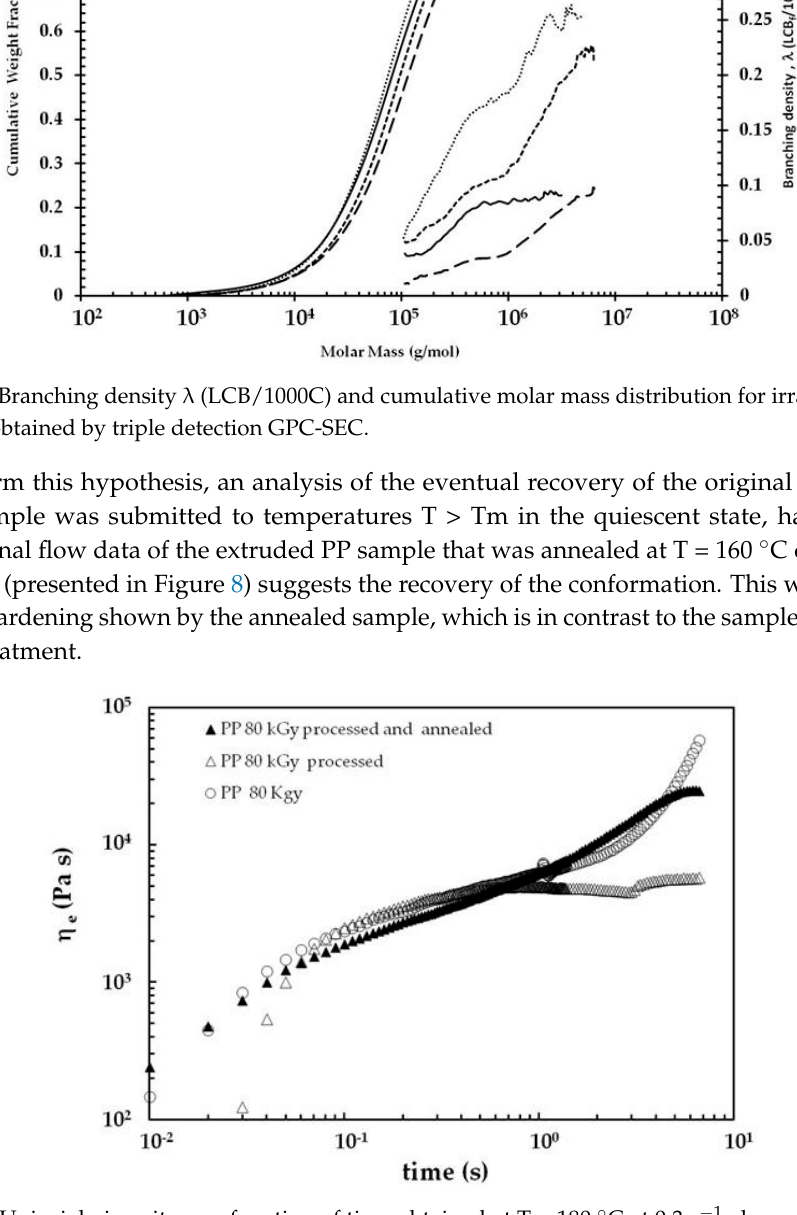
Figure 8. Uniaxial viscosity as a function of time obtained at T = 180 °C at 0.3 s − 1 elongational rate. PP80 KGy is the Irradiated PP distinguished by the strain-hardening behaviour. PP80 kGy processed is the extruded irradiated PP distinguished by the absence of strain hardening. PP80 kGy processed and annealed shows the strain hardening behavior, which has been recovered during the annealing process at T = 160 °C in a vacuum oven during 8 h.